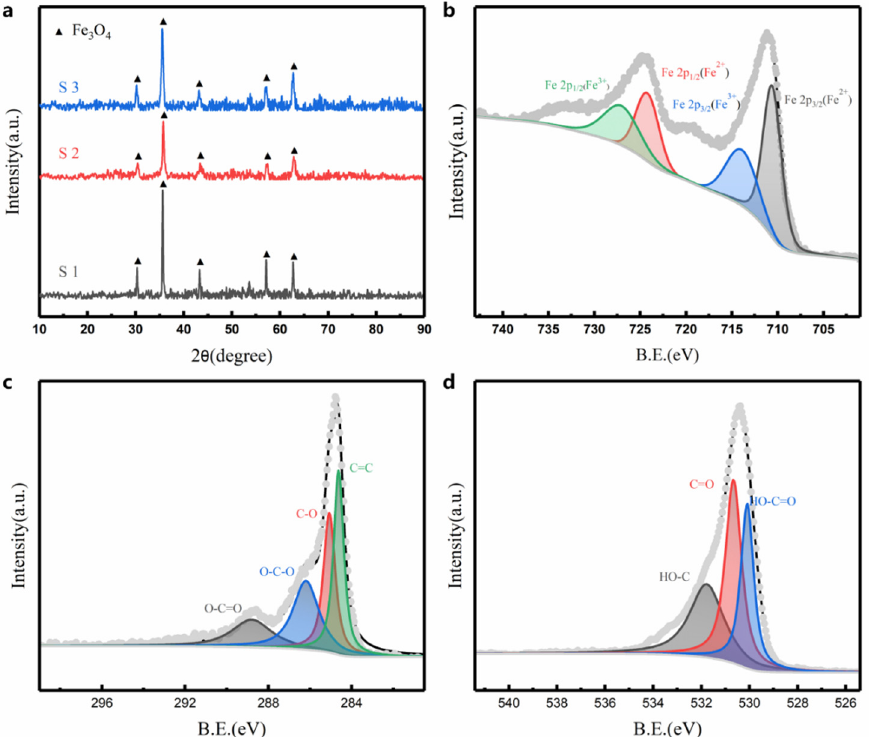
Figure 3. ( a ) XRD patterns of annealed Fe 3 O 4 @rGO. High-resolution XPS spectra of ( b ) Fe 2p, ( c ) C 1s and ( d ) O 1s.